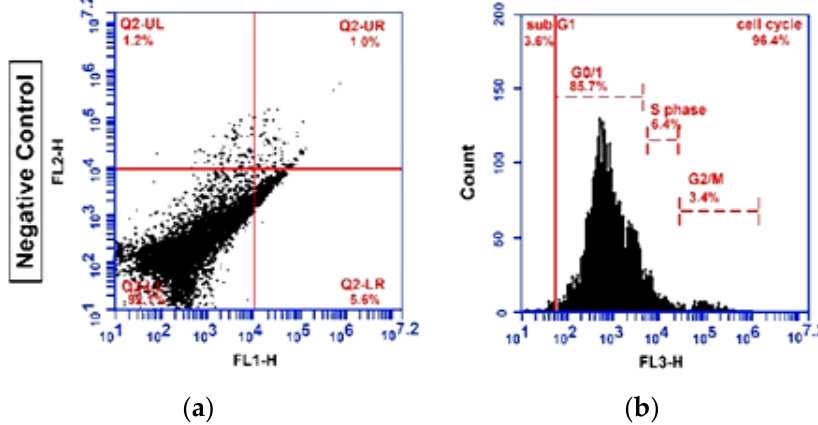
Figure 3. Flow cytometry analysis of negative control cells acquired without stain for: ( a ) annexin and ( b ) promidium iodide.